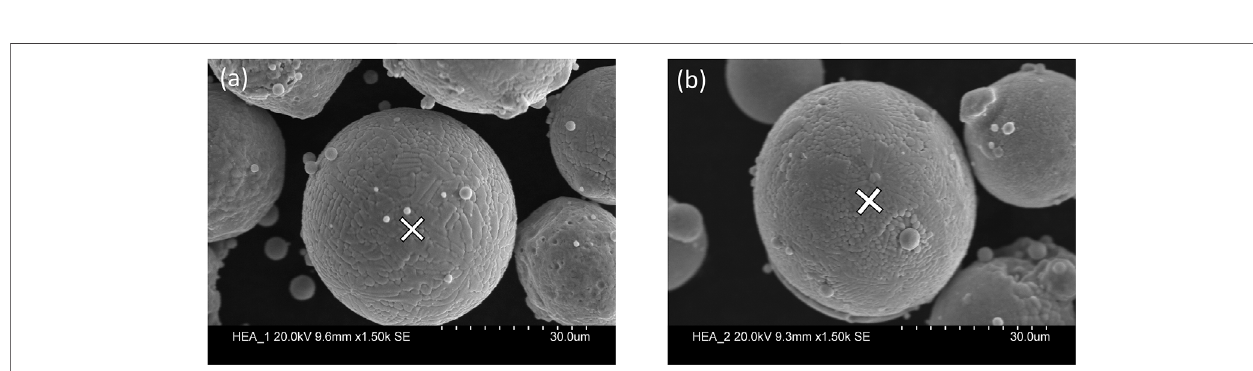
FIGURE 4 | SEM images of the Cantor alloy powder (A) and AlCrMnFeNi powder raw material (B) .